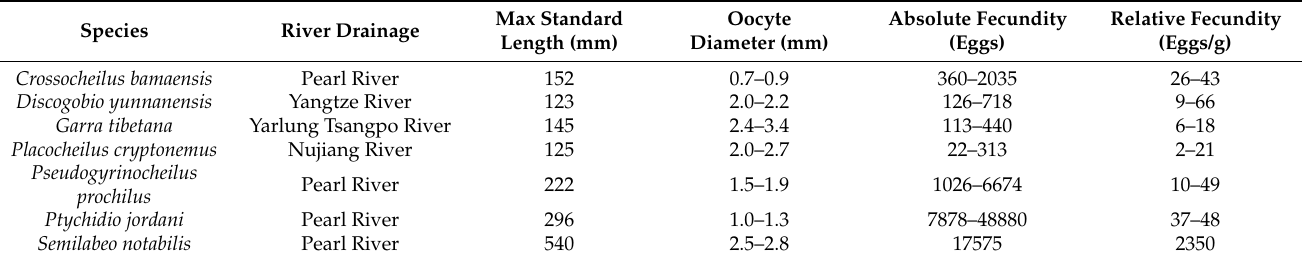
Table 2. Comparison of the fecundity and oocyte diameter characteristics of several labeonine fishes from different river drainages in